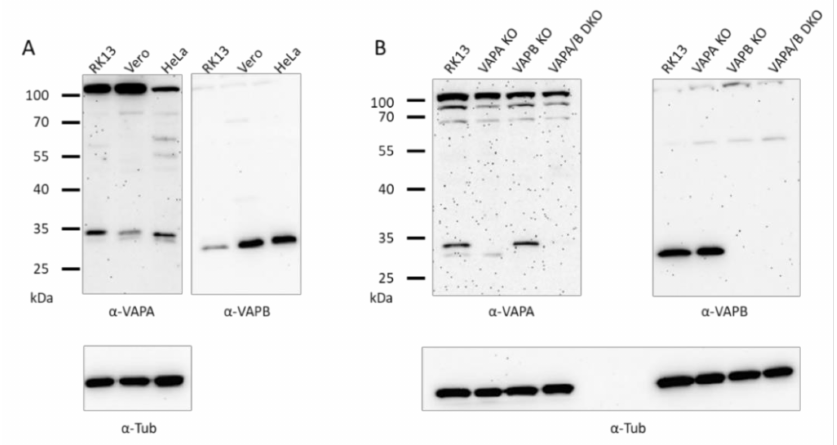
Figure 2. Immunoblots showing VAPA and VAPB in RK13, Vero and HeLa cells and the absence of VAPA and/or VAPB in the corresponding RK13 KO and DKO cell lines. Proteins in lysates of RK13, Vero and HeLa cells ( A ) or RK13 and the single as well as the double VAP KO cell lines ( B ) were separated on SDS-10 % polyacrylamide gels, and parallel blots were incubated with polyclonal sera against VAPA or VAPB. Masses of marker proteins are given on the left in kDa. As loading control,